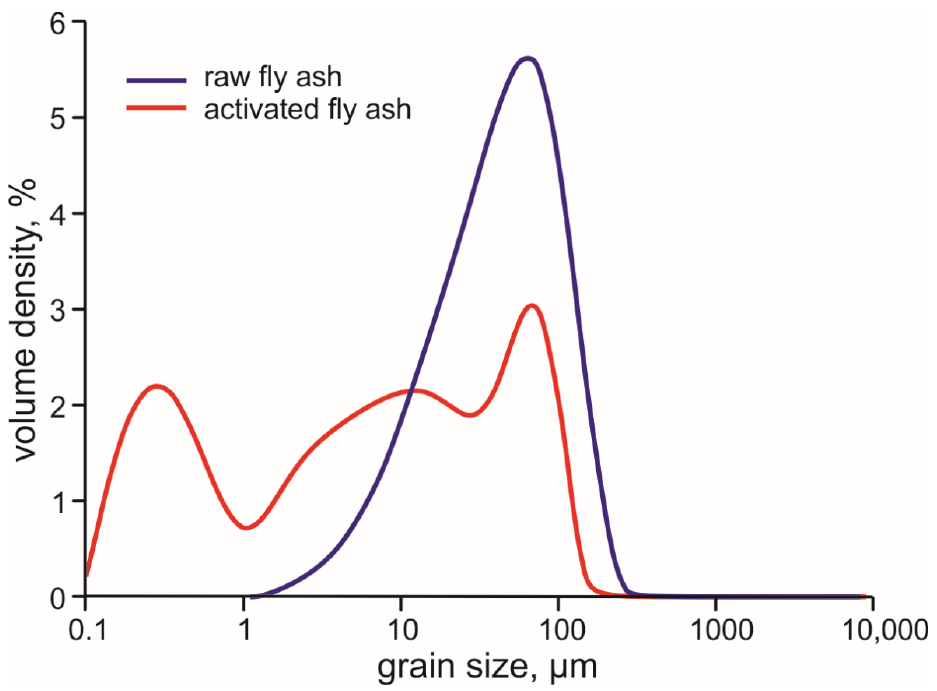
Figure 1. Grain size distribution of the raw and mechanically activated CFBC fly ash.